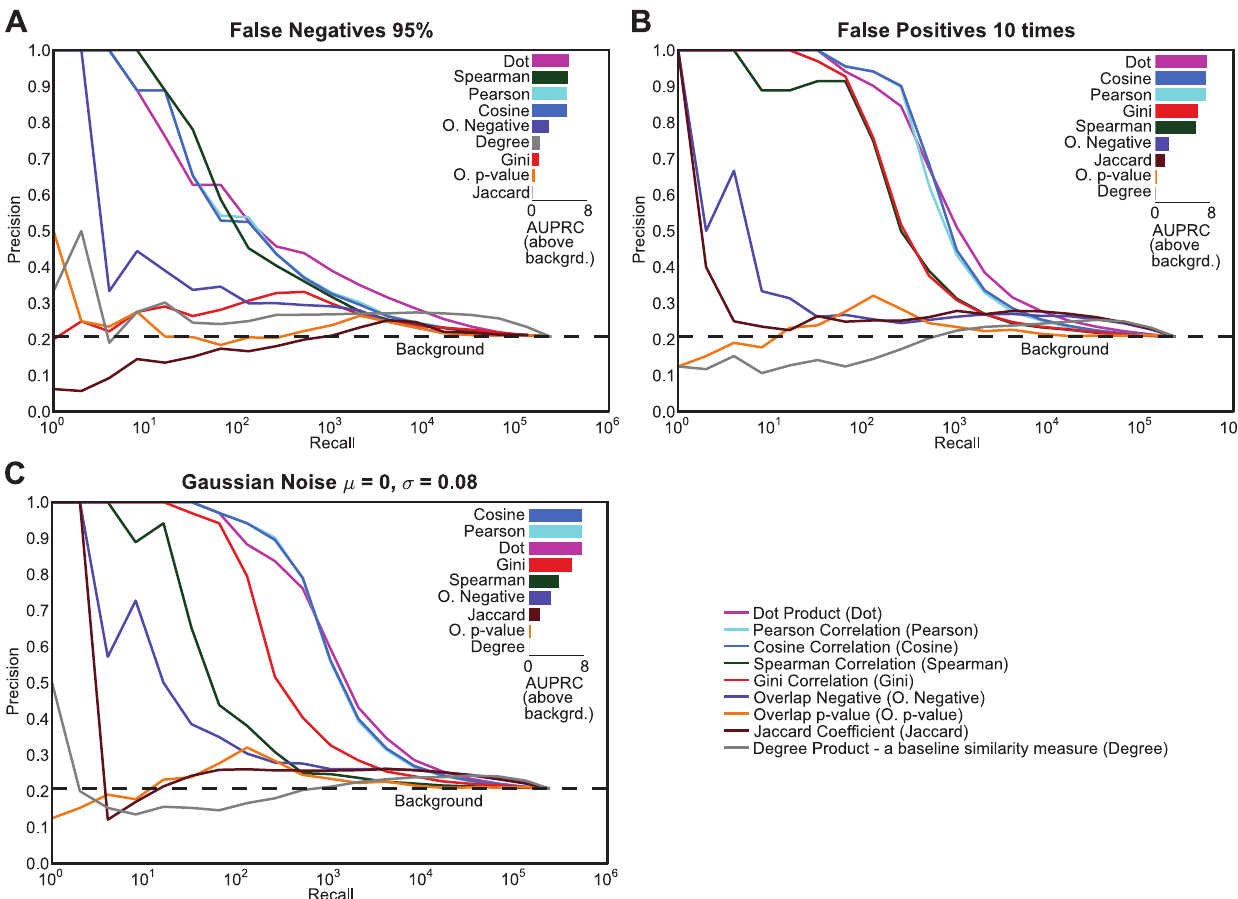
Figure 5. Role of noise in the genetic interaction data on similarity measure performance. In each panel, simulated noise was added to the S. cerevisiae genetic interaction data, and query correlations were used for comparing the similarity measures. The simulated noise conditions are (A) false negatives –95% of the significant interactions whose absolute value of interaction is greater than 0.08 were randomly set to 0, (B) false positives – values were randomly sampled from the set of genetic interactions whose absolute interaction value were greater than 0.08 and were randomly substituted in place of randomly selected non-interactions. This random sampling was repeated until 10 times the number of significant interactions were added as false positives in the original data, and (C) Gaussian noise - random values from a Gaussian distribution of mean 0 and standard deviation 0.08 were added to all values (interactions and non-interactions) in the dataset. The bar plot on the upper right corner in each section shows the area under the precision-recall curve (AUPRC) above the background for each similarity measure. The area was calculated by summation of the areas of trapezoids at in increments of 2 n (log 2 units). The bars are sorted by their respective areas above background.